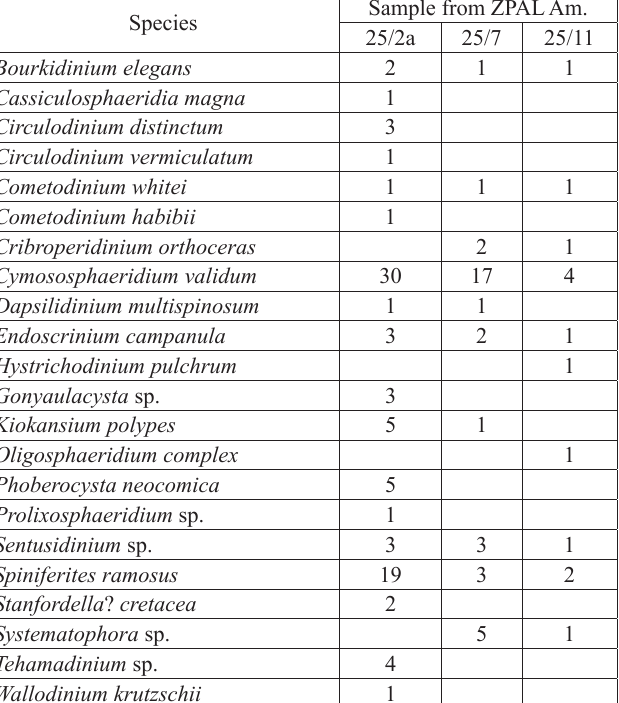
Table. 1. Occurrence of organic­walled dinoflagellate